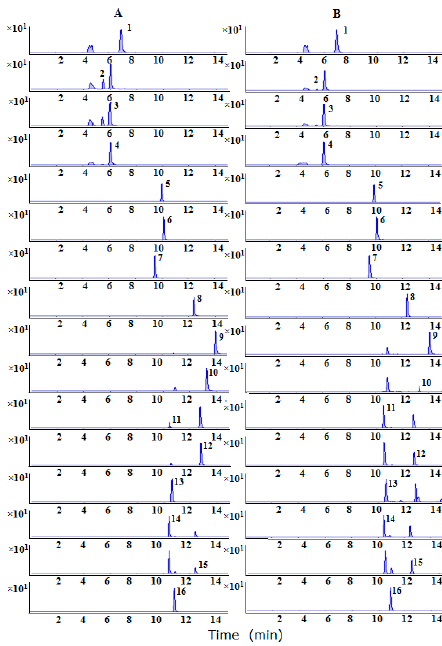
Figure 2. Multiple reaction monitoring (MRM) chromatograms of magnoflorine (1); neochlorogenic acid (2); chlorogenic acid (3); cryptochlorogenic acid (4); astragalinbaohuoside (5); quercitrin (6); hyperoside (7); baohuoside II (8); baohuoside I (9); icariside I (10); epimedin B (11); sagittatoside B (12); epimedin C (13); epimedin A (14); sagittatoside A (15); icariin (16); ( A ) standard solution; ( B ) Epimedium sample.